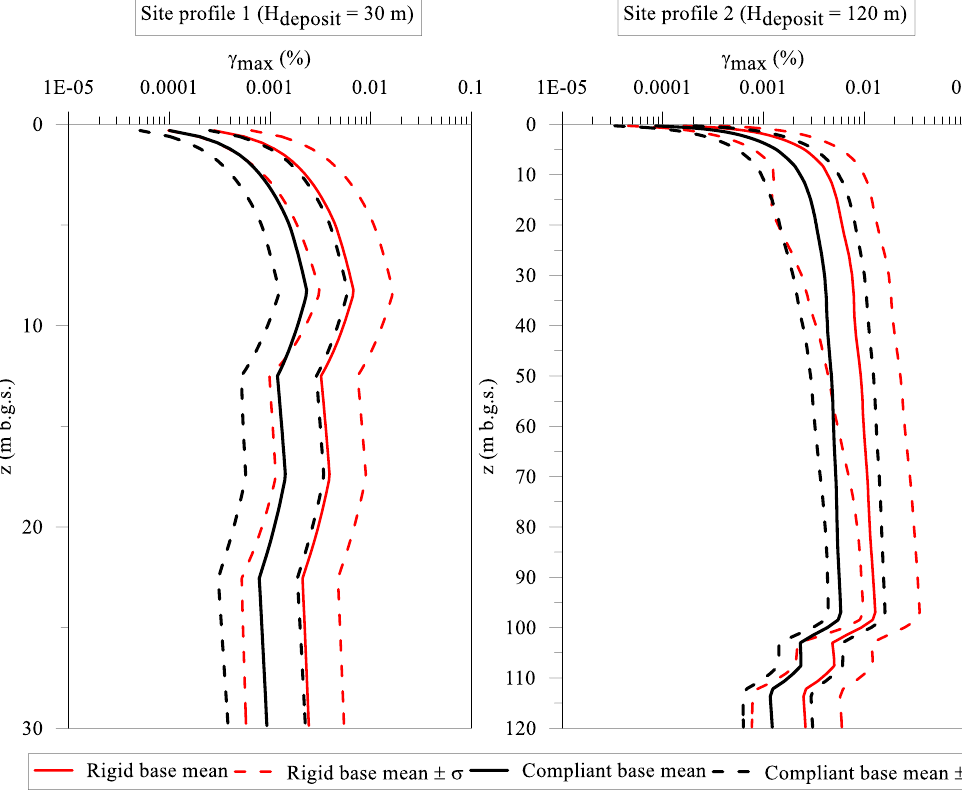
Figure 8. Profiles of maximum shear strain, γ max , with depth referring to the heterogenous site profile 1 (H deposit = 30 m) and to the heterogenous site profile 2 (H deposit = 120 m).